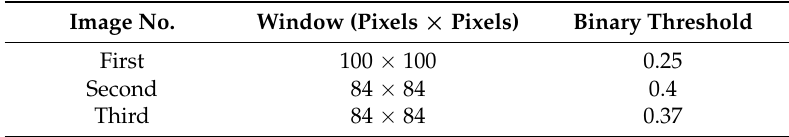
Table 4. The values of the two input parameters of the PanTex method for the three test images. Image No.